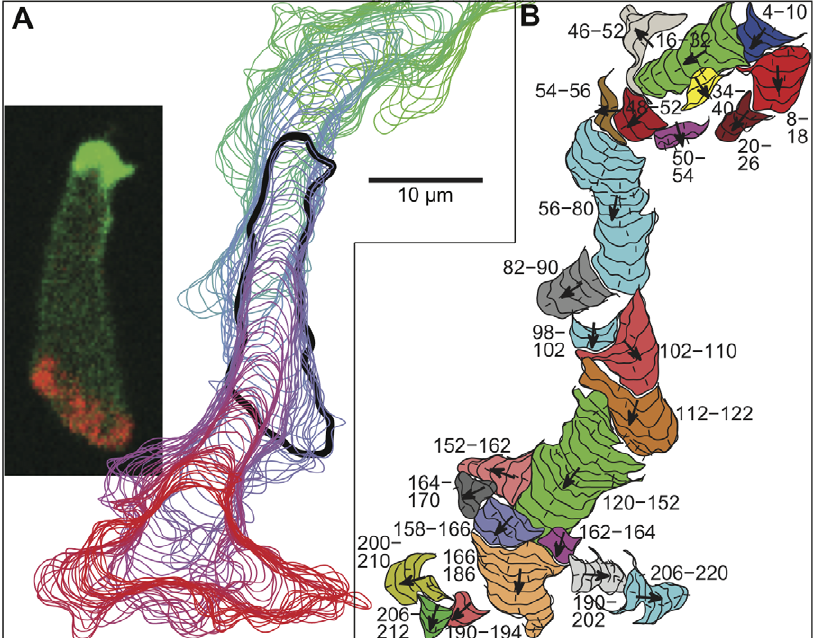
Figure 3. Cell tracks and pseudopods as detected by our algorithm. A) An overlay of cell contours detected in each timestep for a track covering 220 seconds. Images were captured every 2 seconds. The inset displays a fluorescent image of the cell at 120 seconds. Green is GFP-myosin, which localizes to the rear of the cell, red is RFP-LimE, which labels polymerizing actin at pseudopods, and the intensity of each channel was scaled to aid visualization. The outline in (A) corresponding to the inset image is black and in bold. B) Detected pseudopods and their component membrane extensions. Labels indicate pseudopod beginning and ending times in seconds, small hash lines show the direction of each individual extension, and arrows show the entire pseudopod’s mean extension direction. See also Movie S1.